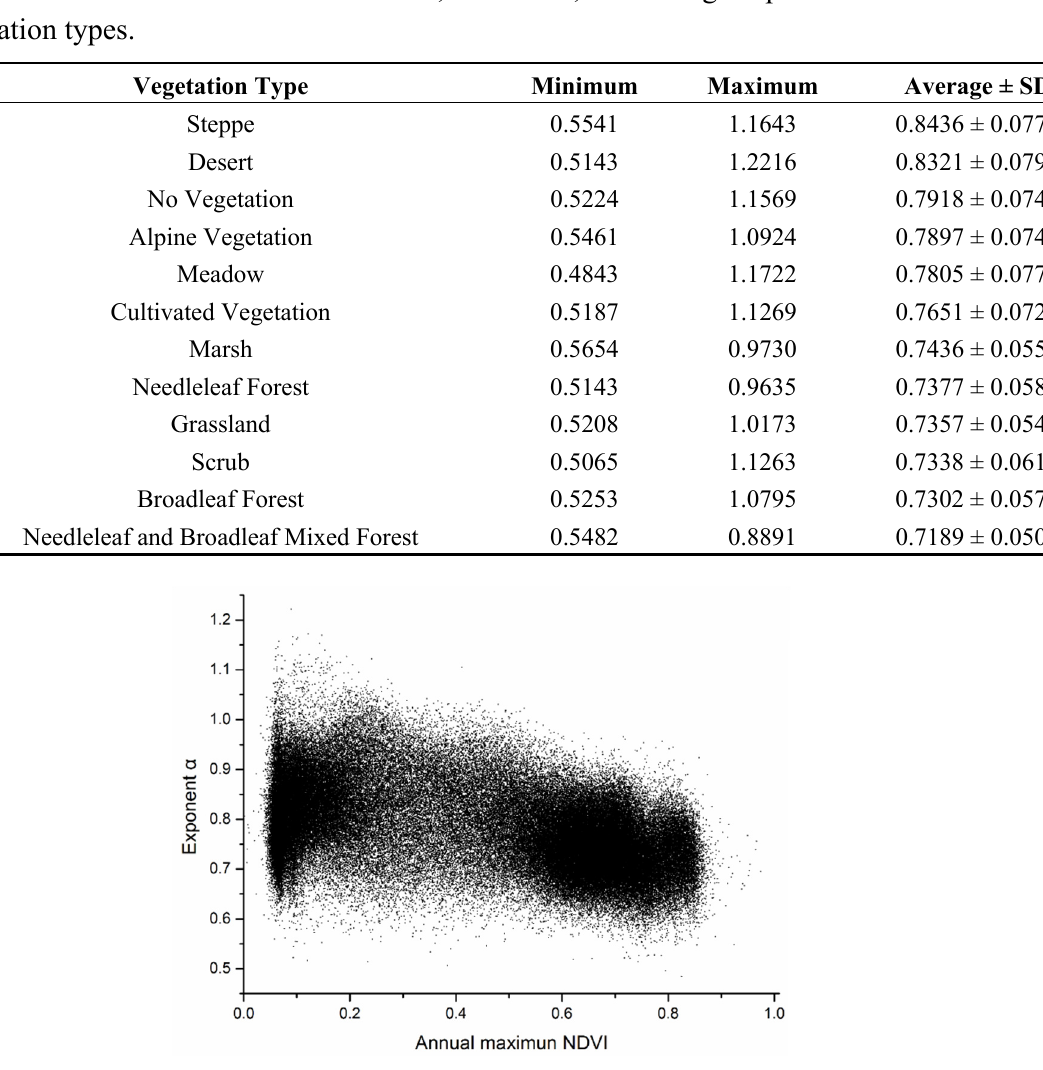
Figure 8. Scatter plot of exponent α and annual maximum NDVI for all of